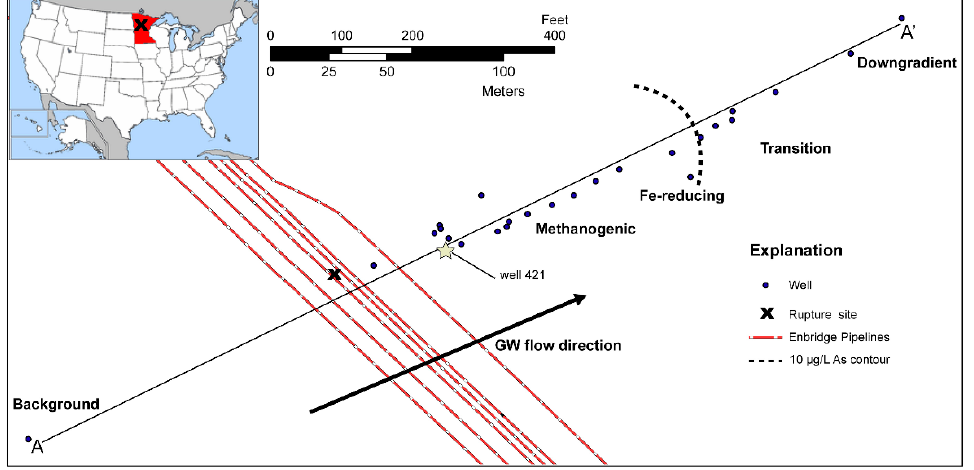
Figure 1. Map of the Bemidji crude oil spill site along the center-line transect of the contaminant plume (A-A’). Blue circles are wells sampled between 2011 and 2015. Well 421 (denoted by a star) is the approximate center of the oil body and is the zero-reference point for this study. Values for background aqueous phases used for initial conditions and constant concentration fluxes are determined from the upgradient well labeled “Background”. The 10 µg/L As contour is from Cozzarelli et al. [29].